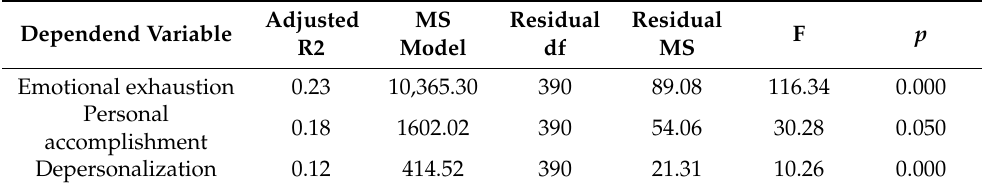
Table 3. Multiple regression analysis results for emotional exhaustion, personal accomplishment, depersonalization, and coping